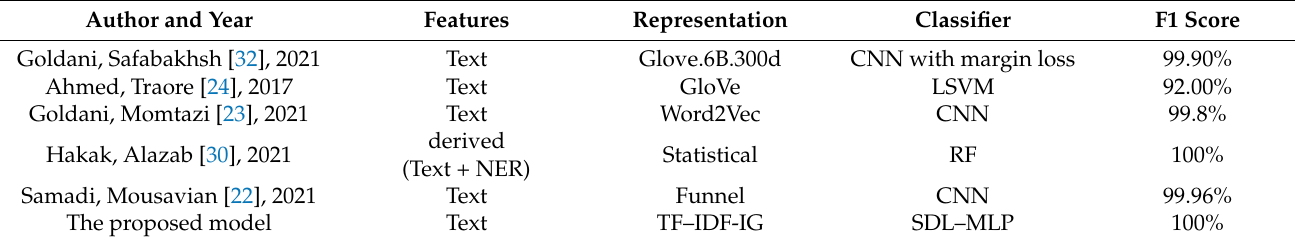
Table 6. Classification Accuracy of the Models using ISOT